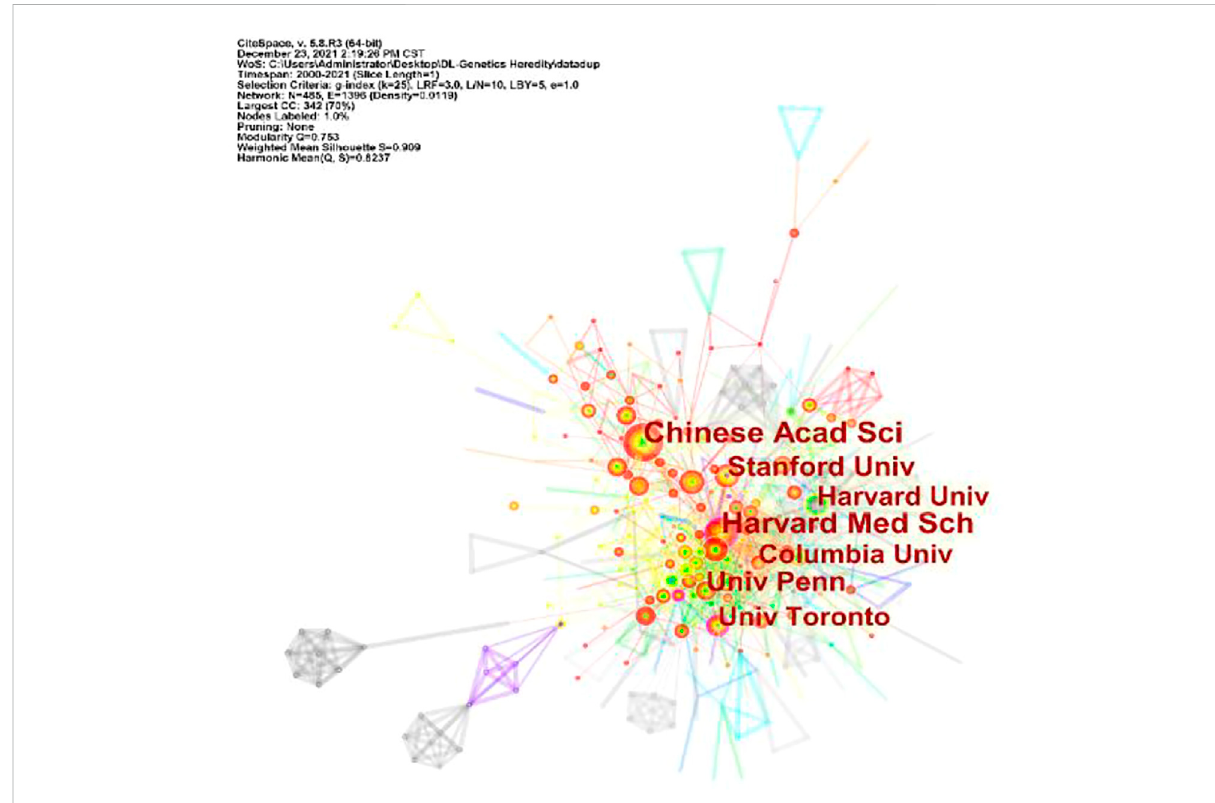
FIGURE 3 Cooperation of institutions contributed to publications for Deep Learning applications in genetic